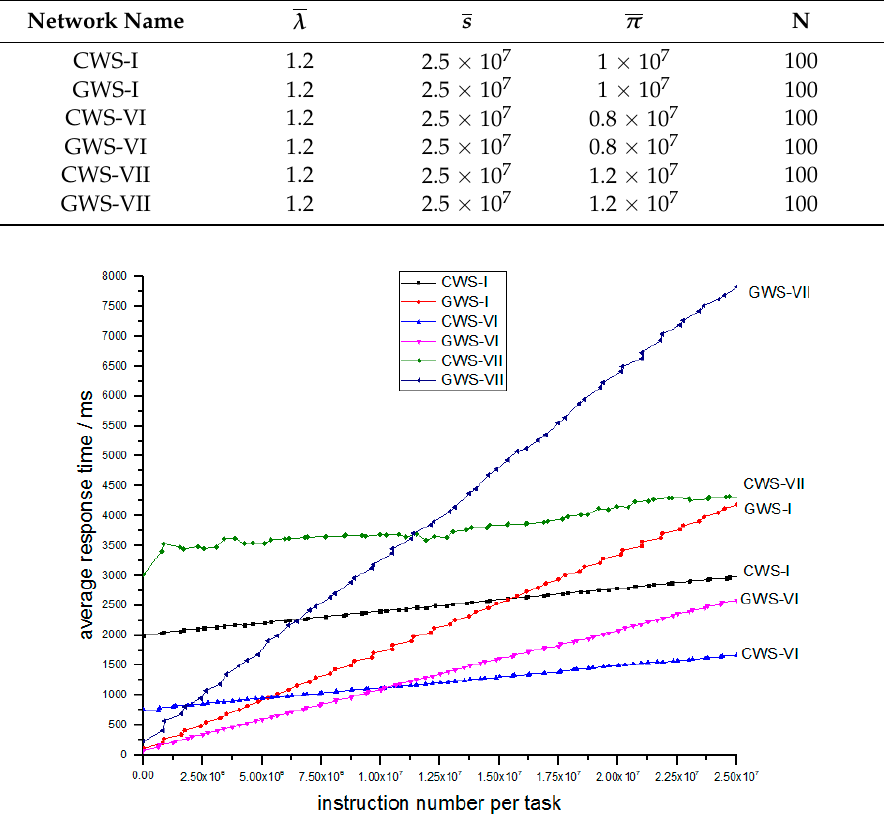
Table 6. Parameters of Simulation V.